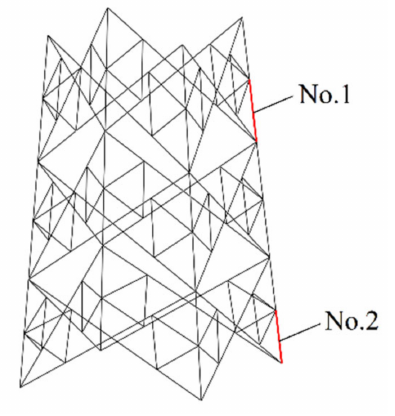
Figure 5. Positions of No. 1 and No. 2.